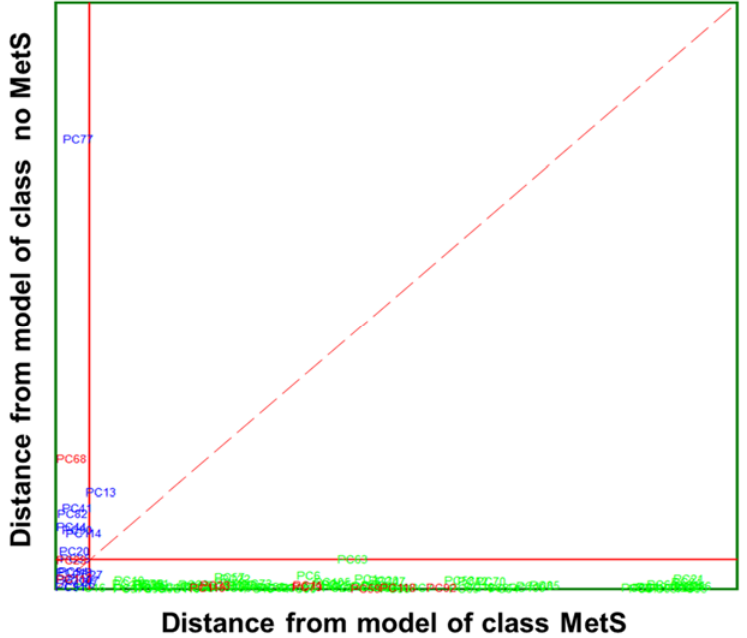
Figure 6. Cooman’s plot displaying the results obtained by applying SIMCA class-modelling to clinical parameters: MetS ( ) and no MetS ( ) patients within the included ( ) test set. The red solid line indicates a confidence level for class space at 95%. The red dashed line indicates equal class distance.